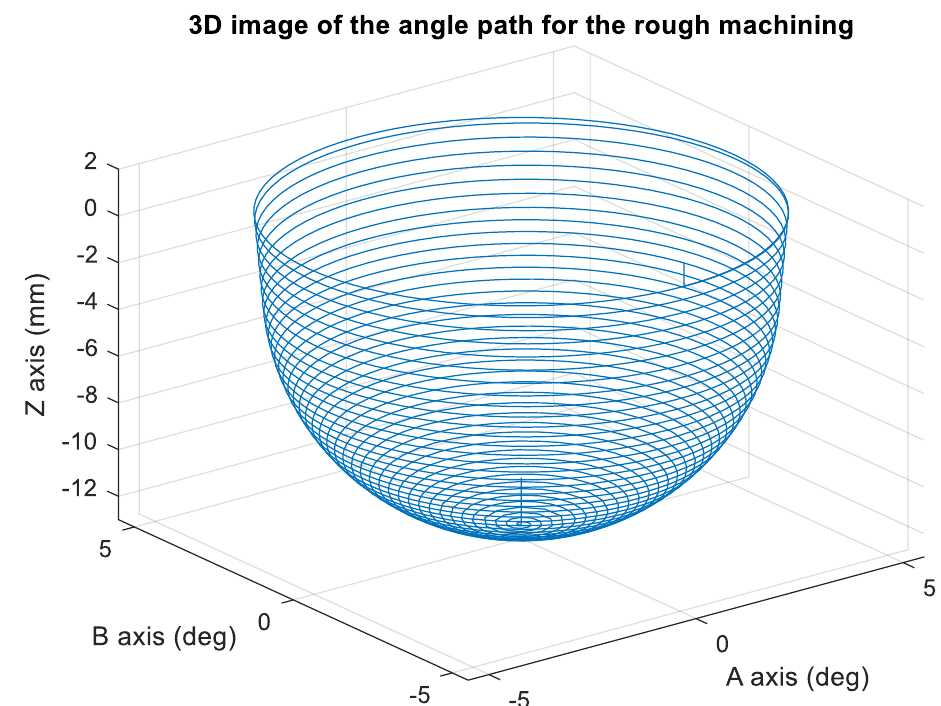
Figure 12. Three-dimensional image of the angle path with Z axis for the original rough machining program.